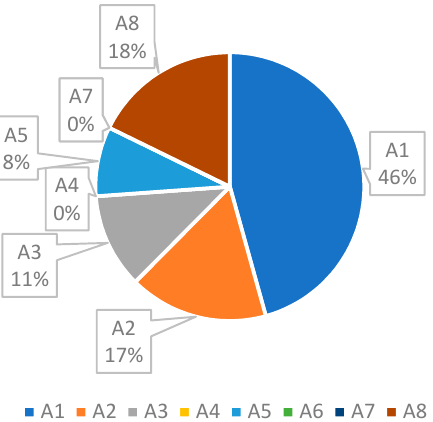
Figure 7. Waiting time in various wards of the heart clinic (current situation).